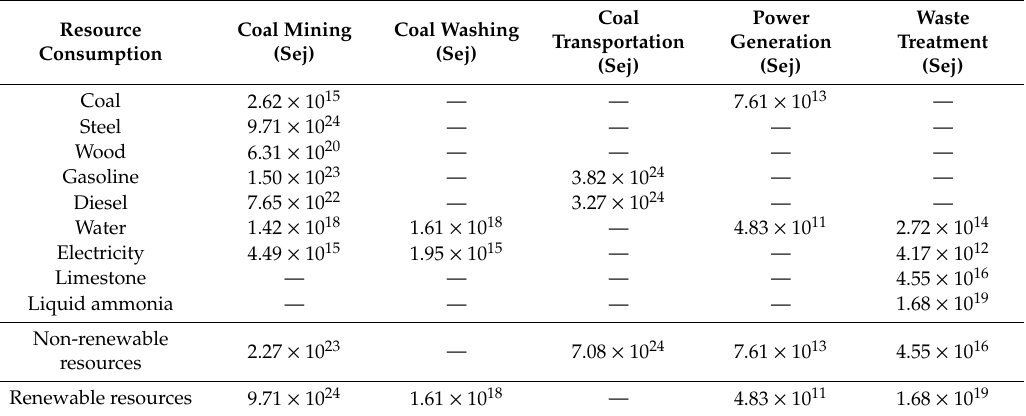
Table 5. Life cycle resource consumption of Unit 1.